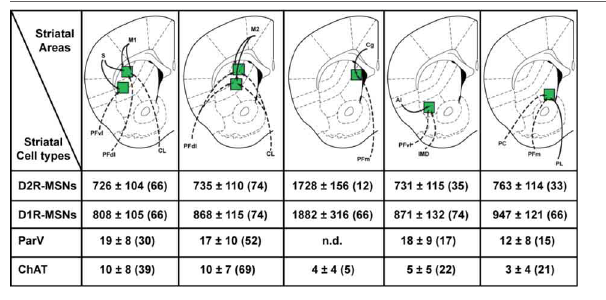
Table 1 | Density of MSNs, parvalbumin GABAergic and cholinergic interneurons in the different striatal sectors analyzed at the rostral level of the dorsal